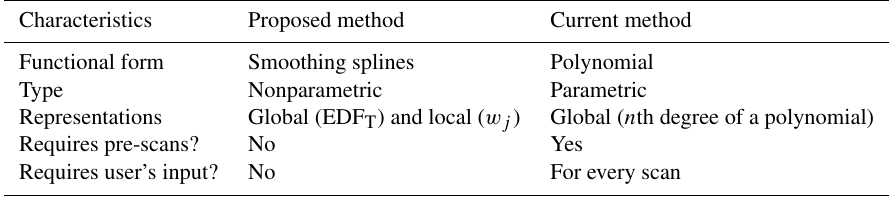
Table 2. Comparison of key background modeling characteristics pertaining to the proposed and current models